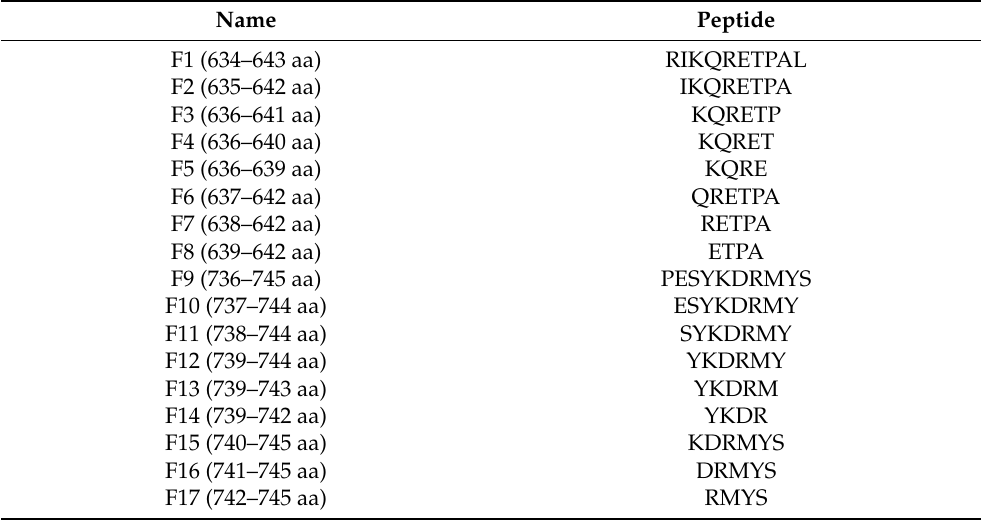
Table 1. Sequences of peptides synthesized in this study.